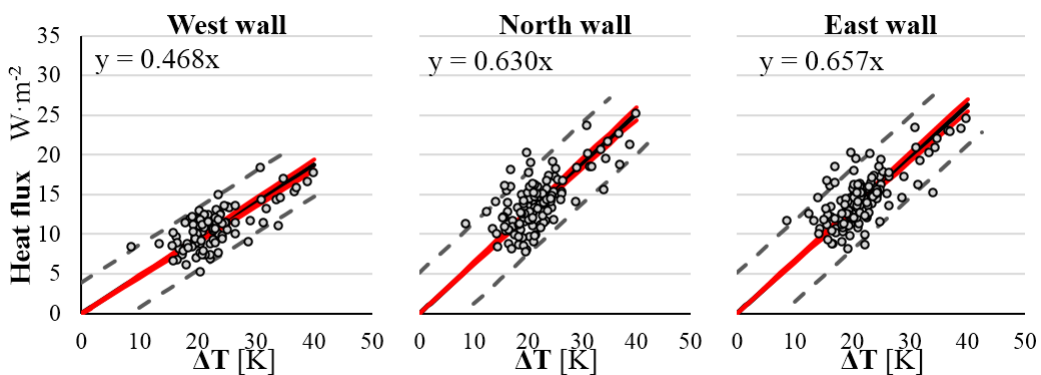
Figure 6. The thermal transmittance of the large wall segment calculated using thermography for the west wall (left figure), north wall (centre figure) and east wall (right figure) with confidence interval of 95% certainty (red lines). The Y-axis represents the conduction heat transfer (Q Cond,Large_wall ) calculated by Equation (7). The X-axis represents the difference between the indoor and outdoor ambient air temperatures, ∆ T = (T Indoor – T Outdoor ). The dashed lines represent 95% certainty for measurements to disperse around the mean (black trend-line).